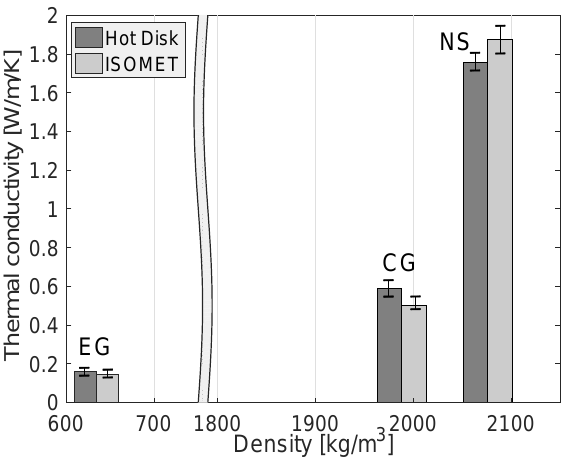
Figure 5. Thermal conductivity of the specimens measured with different